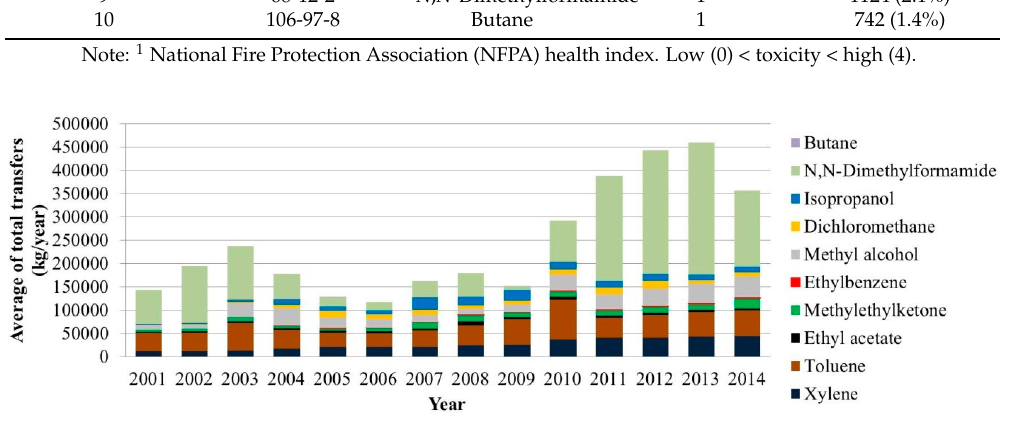
Figure 6. Average total transfers of top 10 chemicals in 42 cities.